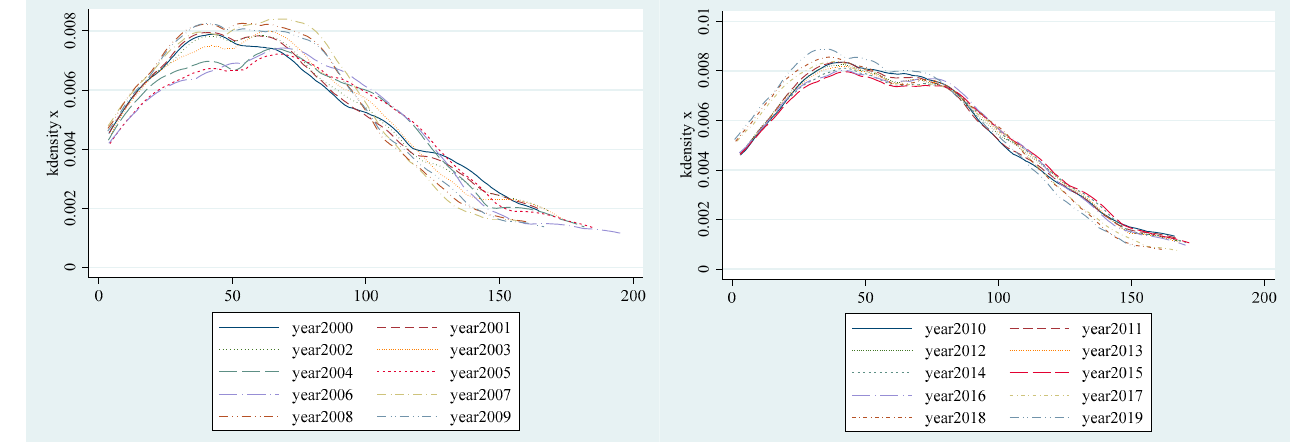
Figure 5. Epanechnikov kernel density function diagram.